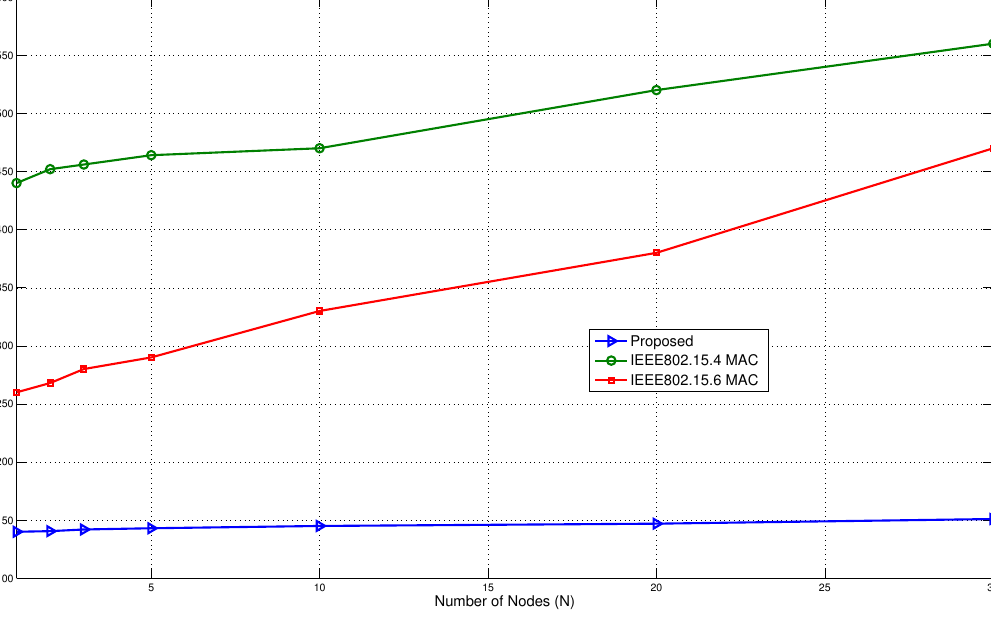
Figure 26. Delay comparison with standard protocols.